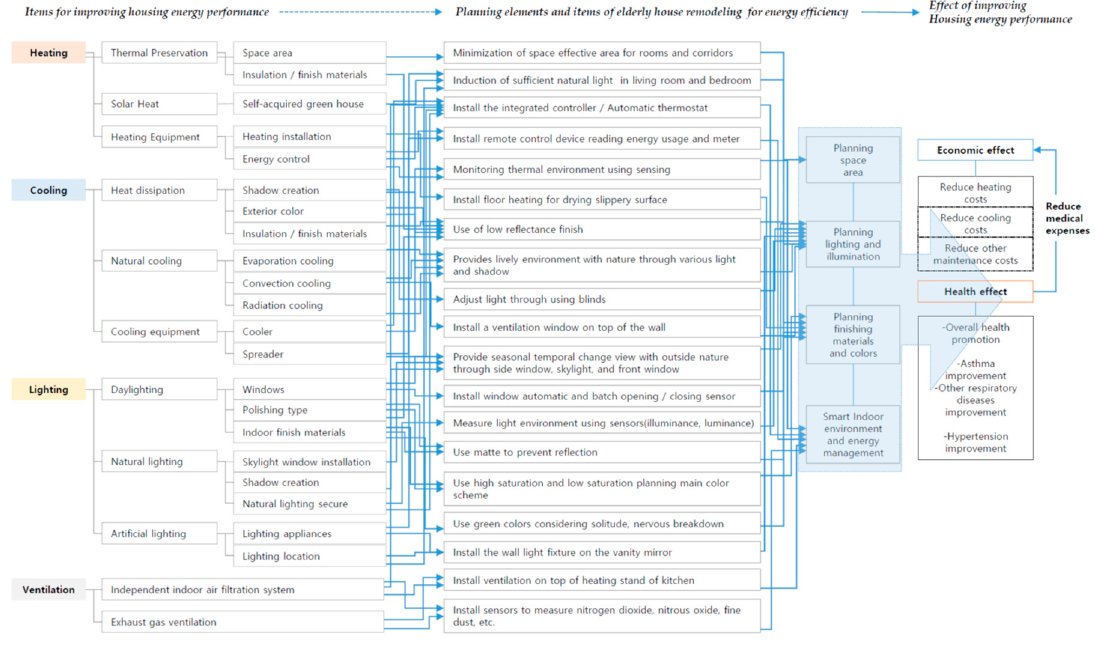
Figure 2. A remodeling system enabling energy efficiency in the housing for the elderly.